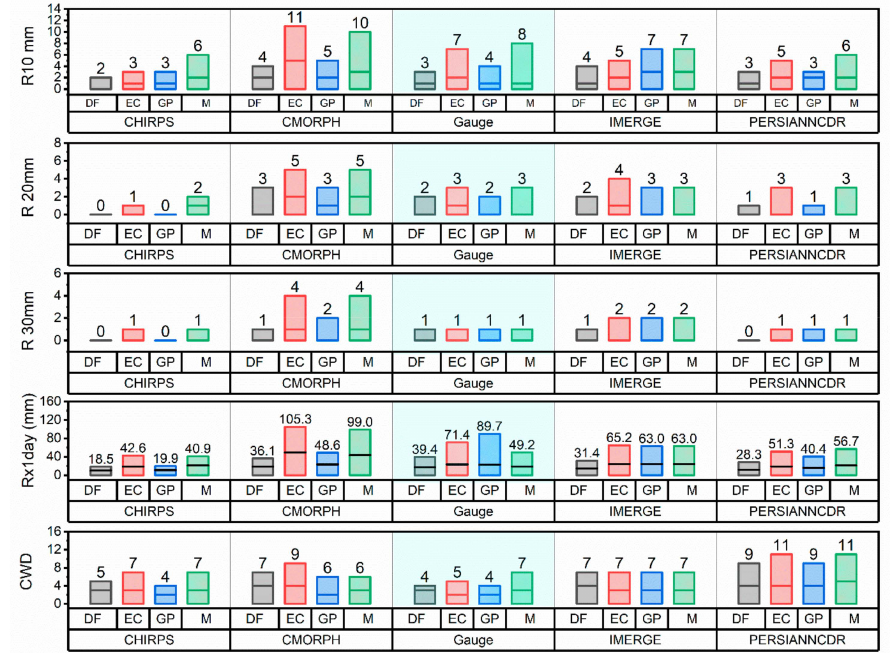
Figure 8. Results of climate indices analysis based on the products and the climatological regions (DF = Desert Foreland, EC = East Coast, GP = Gravel Plains, M = Mountains). CWD is consecutive wet days, Rx1day is the maximum one-day precipitation in millimeters in the given period, and R10, R20, and R30 are the annual count of days when rainfall was greater than 10, 20, and 30 mm,